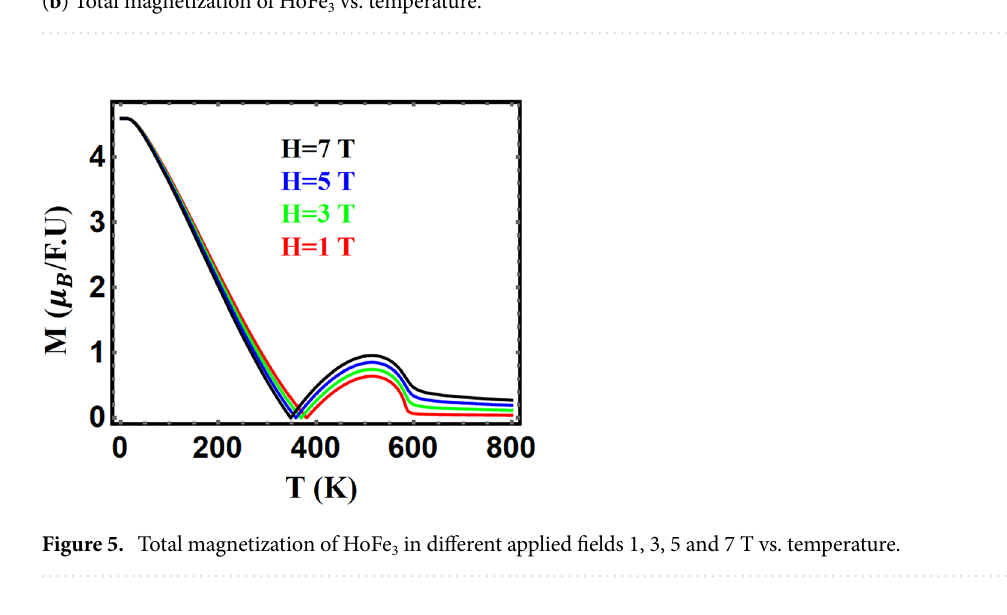
Figure 4. ( a ) Mean-field calculated total and sublattice magnetization of HoFe 3 , in zero field, vs. temperature. ( b ) Total magnetization of HoFe 3 vs. temperature.